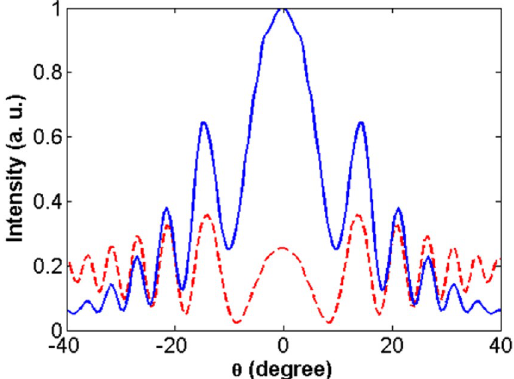
Figure 8. Far-field angular radiation patterns of a bare aperture (dashed-red) and an aperture which is covered with a low-loss ITO as an ENZ medium (solid blue) for Δ = 0 at λ = 1415 nm